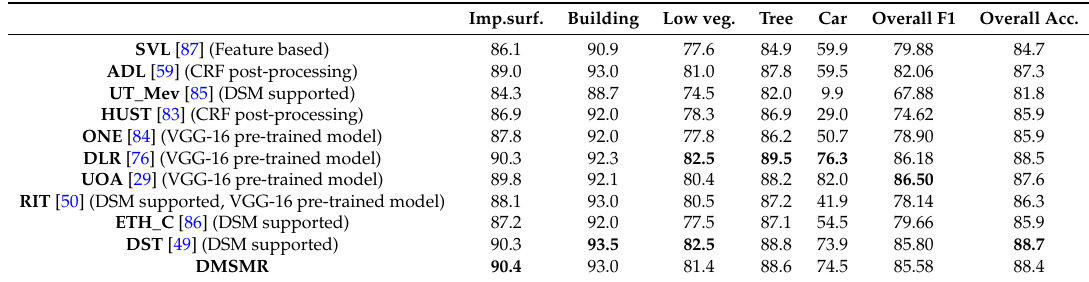
Table 4. Vaihingen dataset [88] results. We compare our proposed approach with a few recent state-of-the-art methods listed on the ISPRS Vaihingen 2D contest leader board. Traditional approaches and methods that employ additional aides (methods with qualifying comments) are referenced for